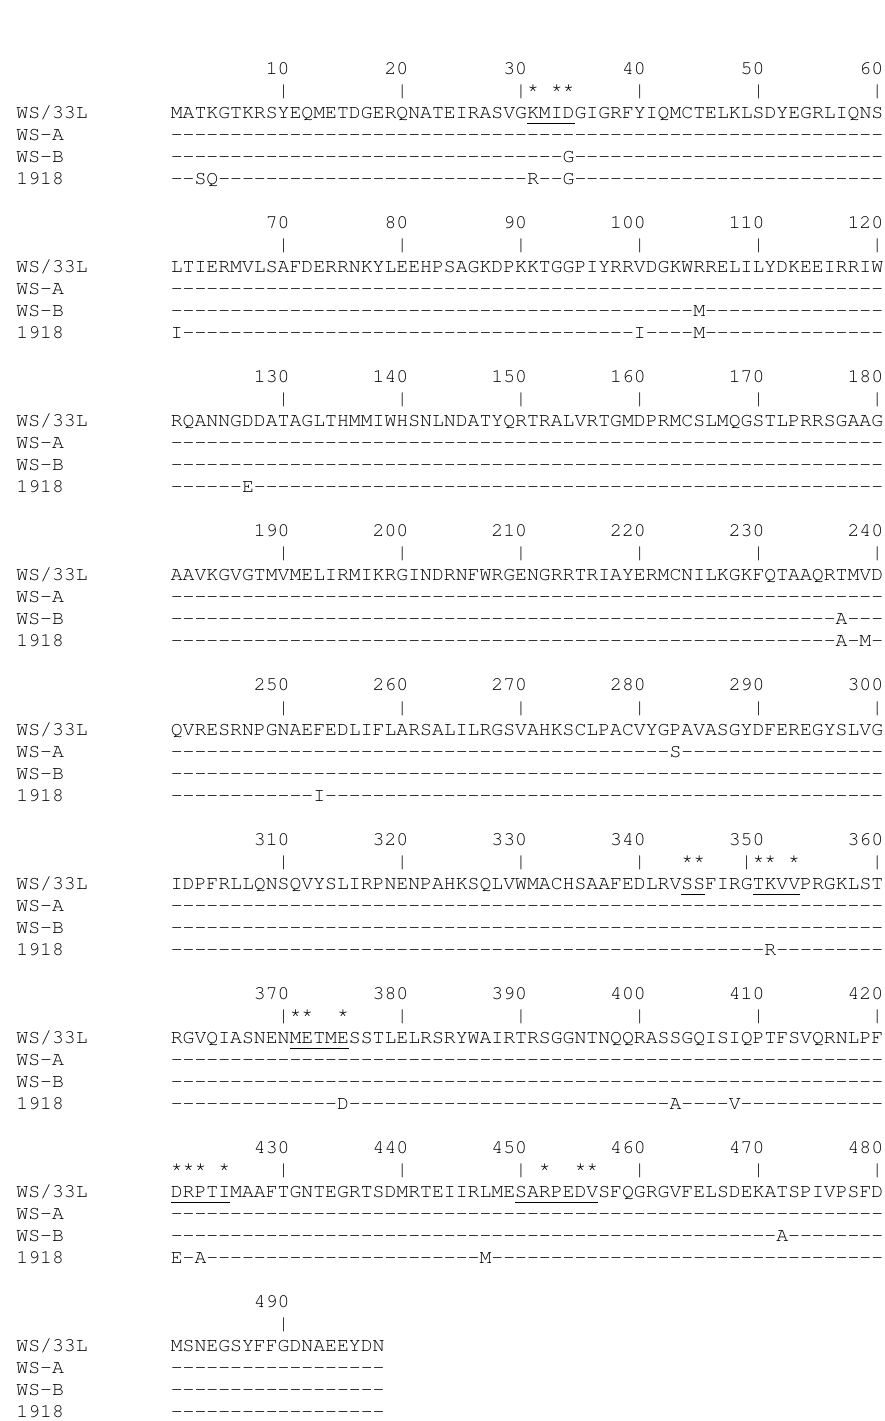
Figure 1 Amino acid (aa) comparison of WS/33 NP sequences. Sequence generated from WS/33L in the present study is com- pared with 5 other WS/33 sequences represented as WS-A [includes sequences EMBL:Q1K9H2, EMBL:AAG41965 and EMBL:ABF21292] and WS-B [includes sequences GenBank:AAA43452 and GenBank:P15682]. NP sequence of the 1918 pan- demic flu strain [GenBank: ] is also included for comparison. Identical amino acids are represented by "-"; Phylogenetically important regions (PIR) are underlined; phylogenetically important positions (PIP) are indicated by an